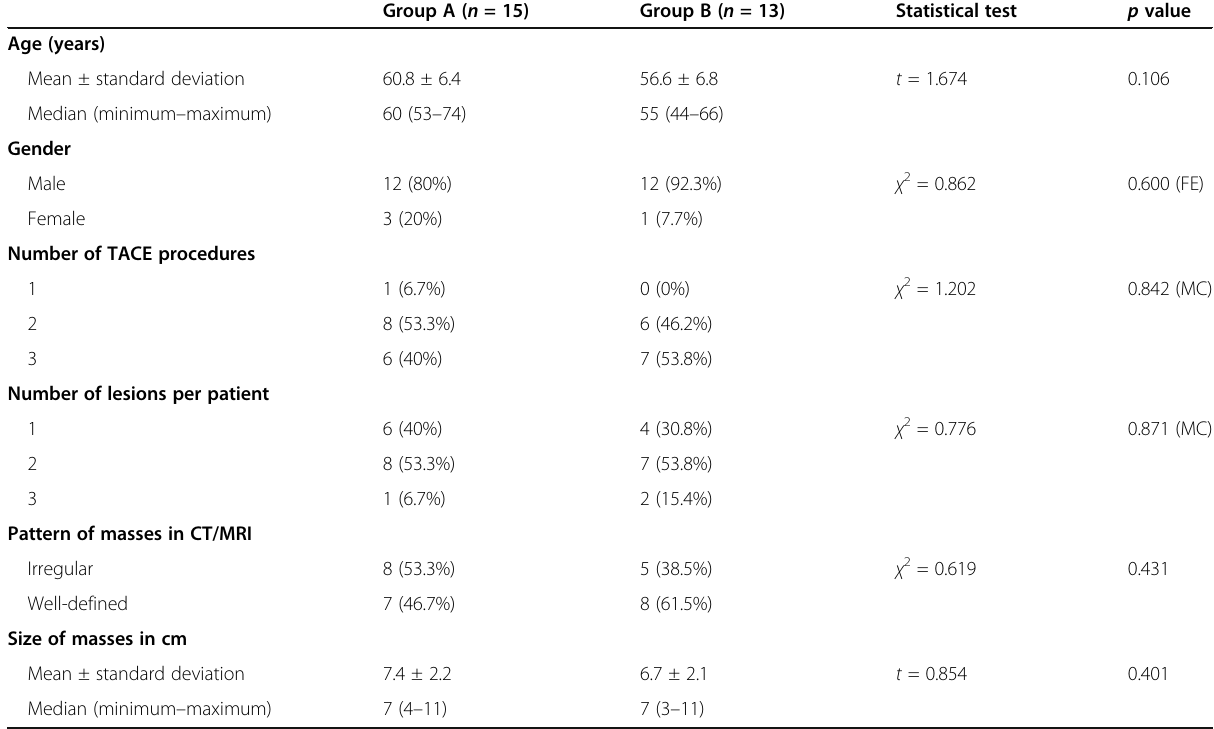
Table 1 Demographic and imaging characteristics of patients in groups A and